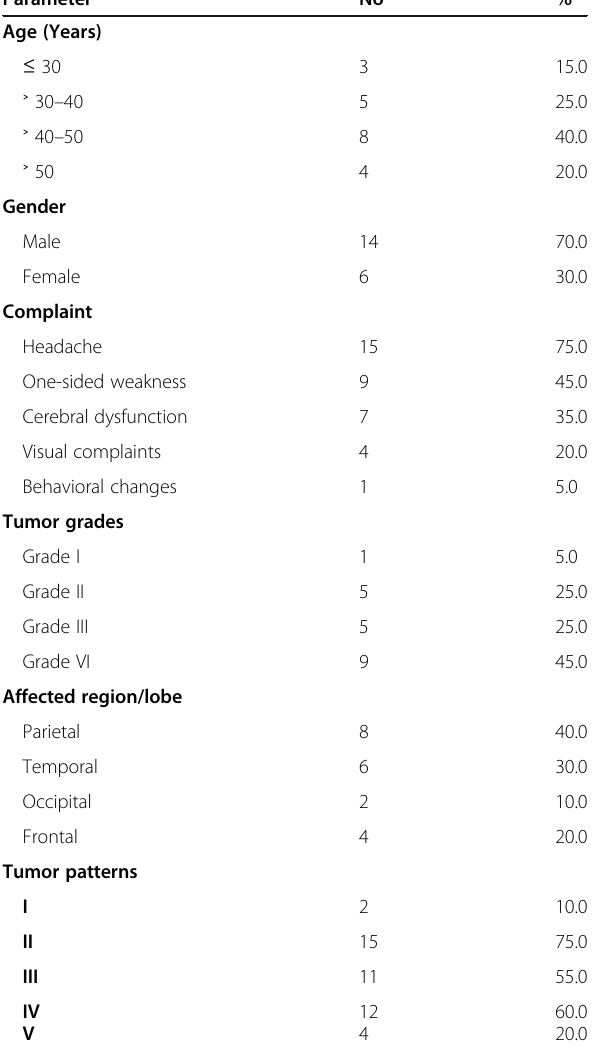
Table 2 Patients ’ and tumors characteristics (total n = 20)